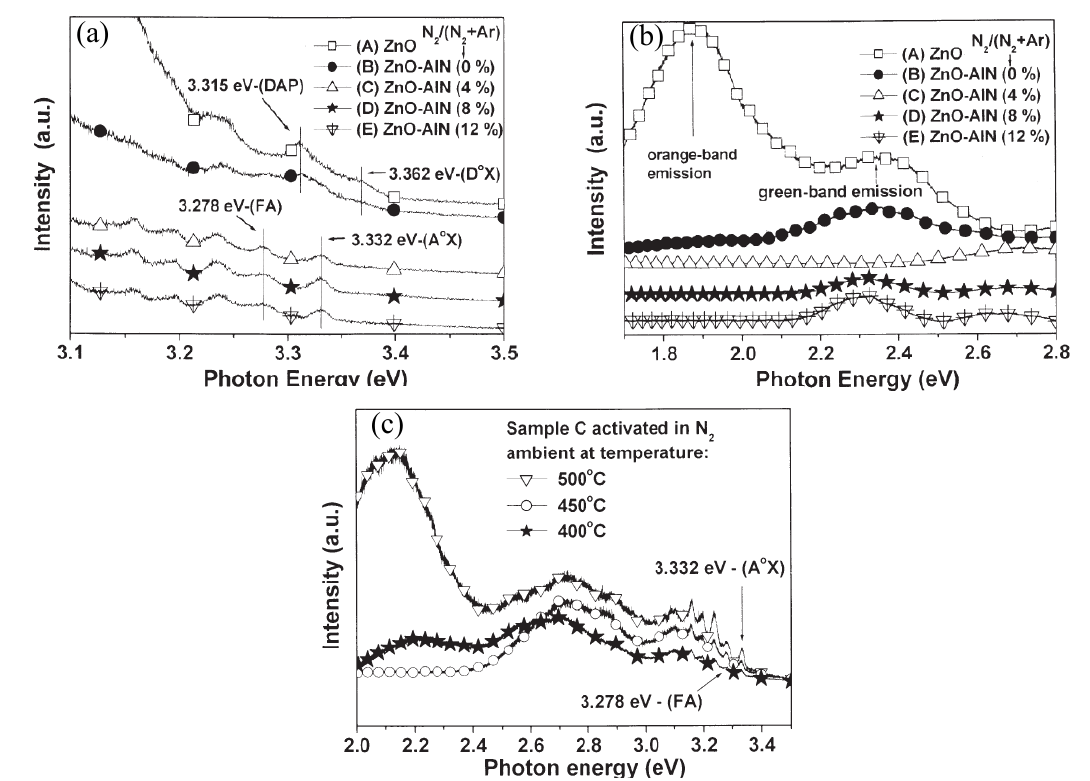
Figure 15. LTPL spectra (10 K) of ZnO and AlN–ZnO [N films annealed at 450 °C (a) in UV emission range. (b) in deep level emission range. (c) LTPL spectra of the AlN–ZnO [N respectively. Reprinted from Ref. [120] with